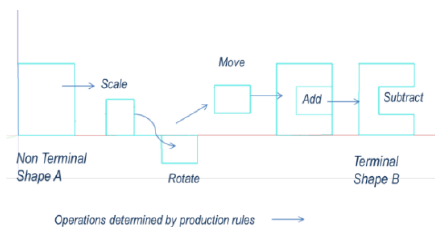
Figure 1 . Shape Grammar Production Rules and